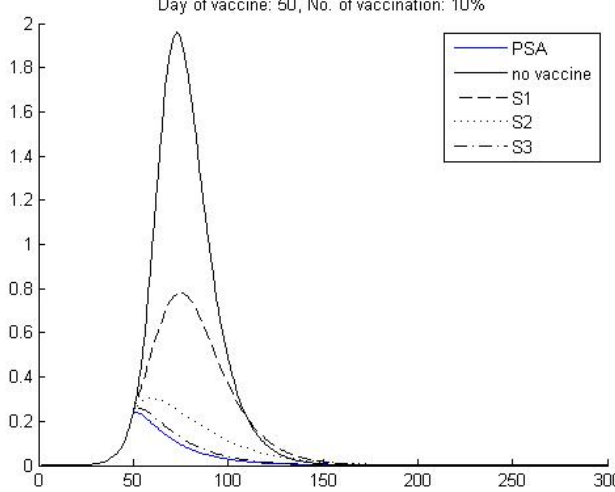
Figure 5. Infection dynamic for 5% vaccination coverage.